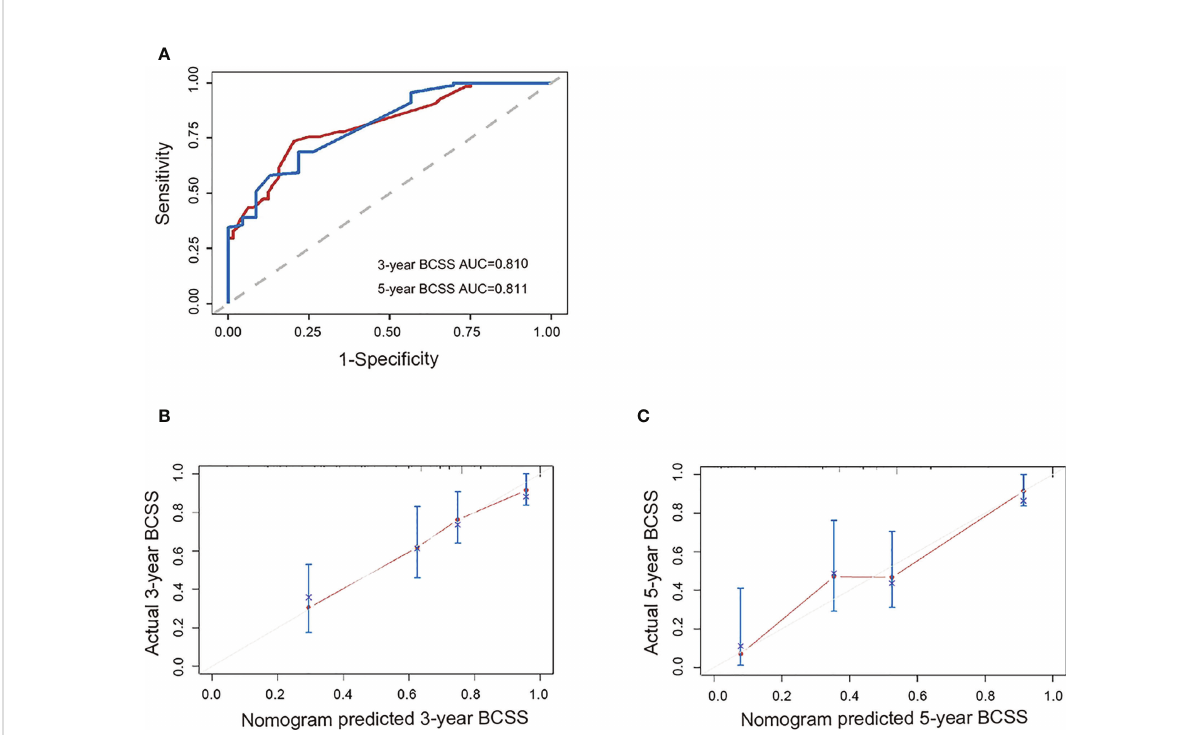
FIGURE 4 External validation of the nomogram. (A) ROC curve for the external validation set, as well as the nomogram ’ s calibration curves in terms of (B) 3-year BCSS and (C) 5-year BCSS. AUC, area under the curve; BCSS, breast cancer-speci fi c survival; ROC, receiver operating